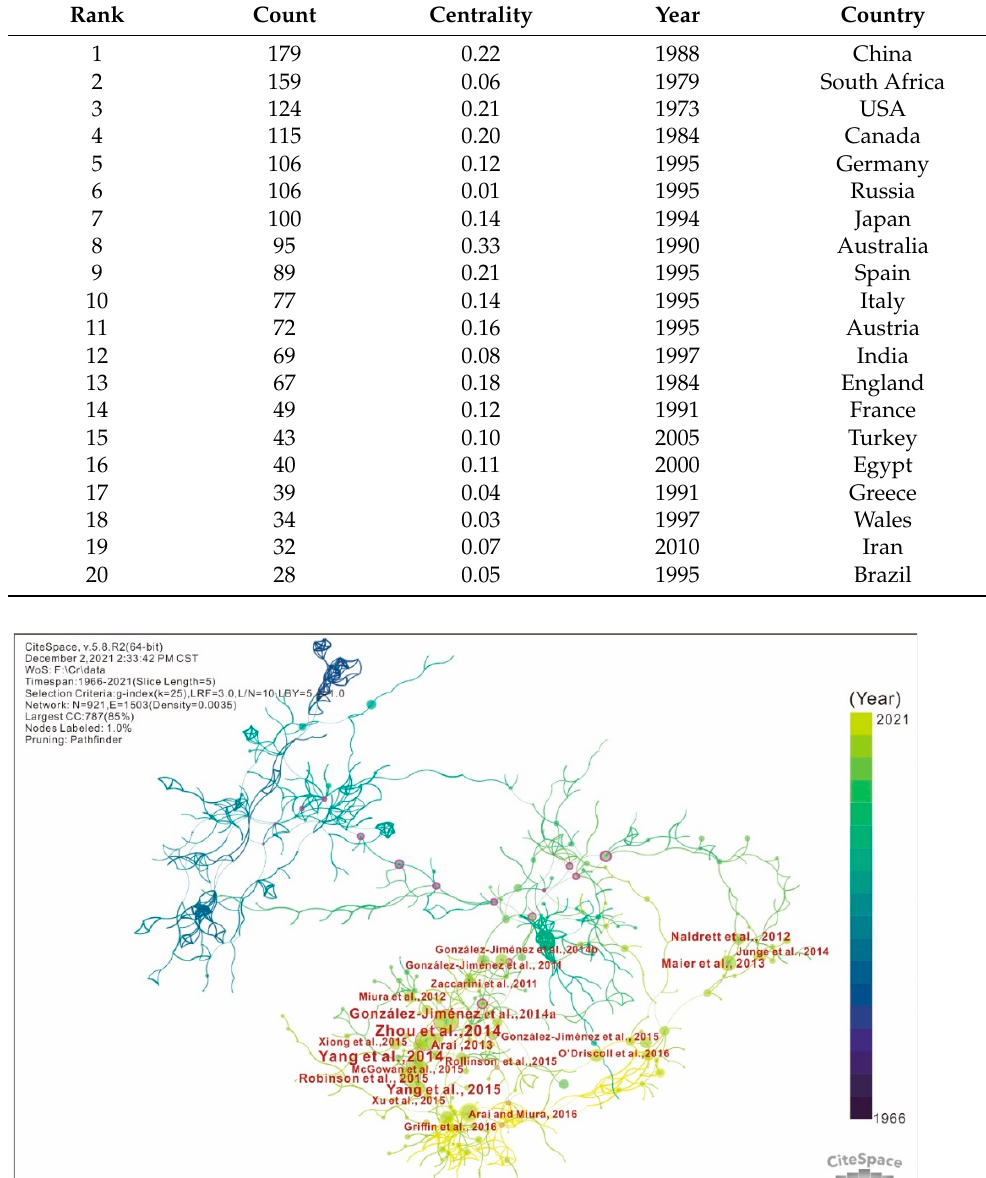
Table 3. Top 20 countries ranked by the number of publications with a focus on chromitite.